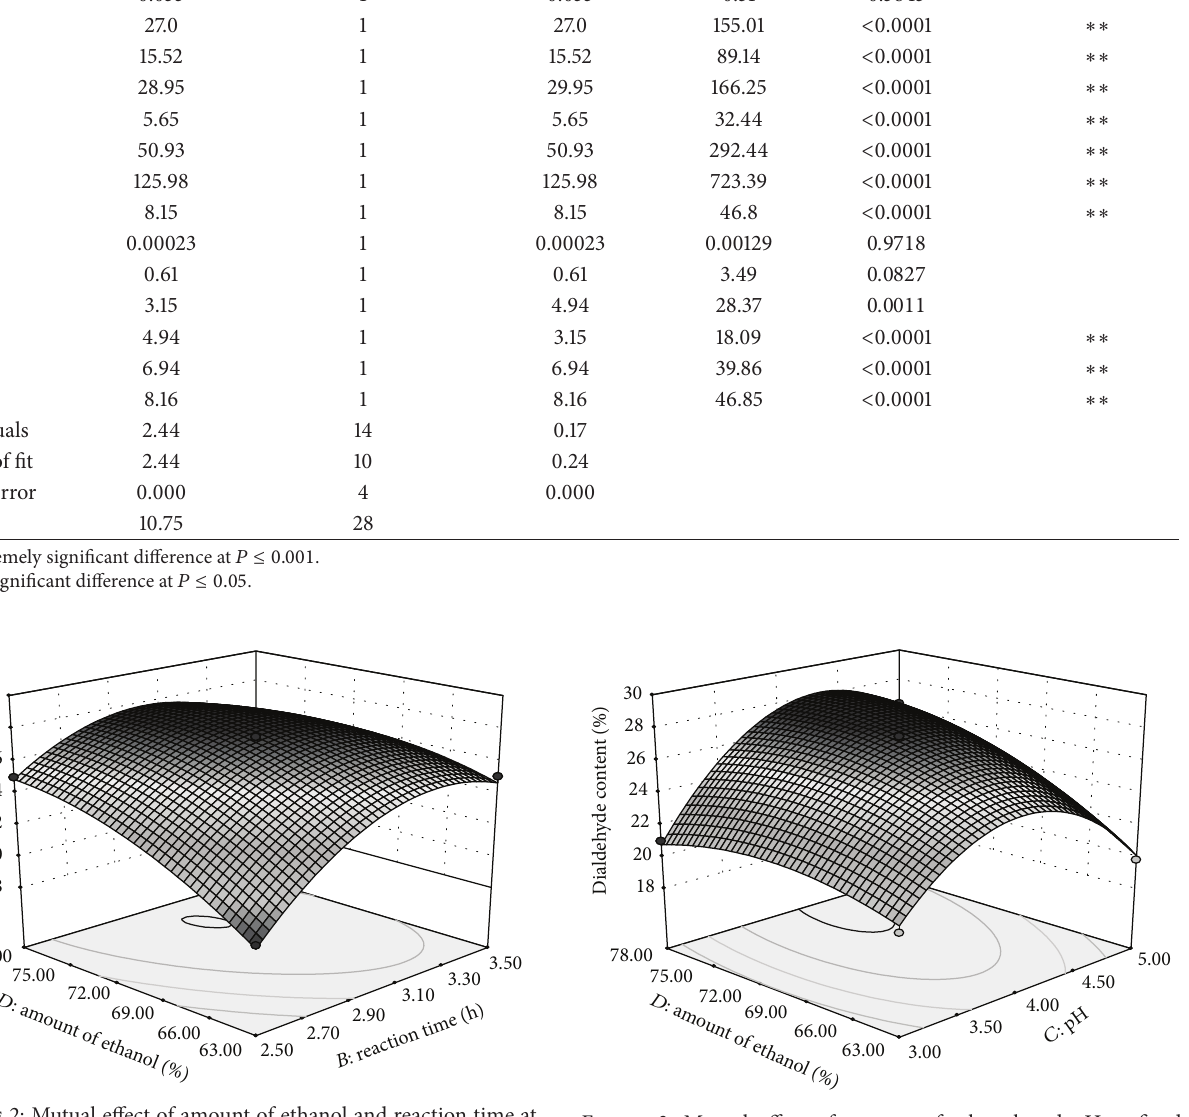
Figure 3: Mutual effect of amount of ethanol and pH at fixed reaction temperature of 40 ∘ C and reaction time of 3